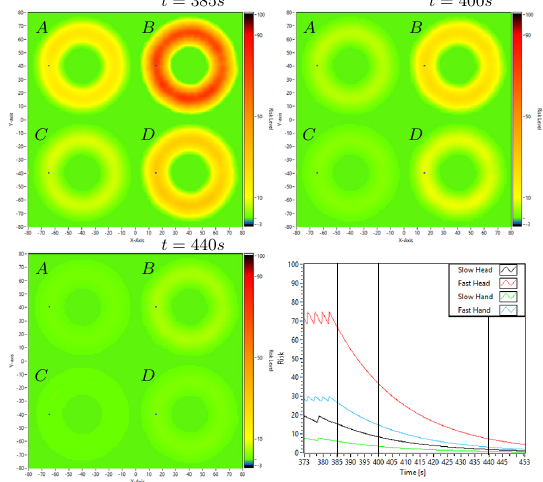
Figure 8: Degeneration of risk over time. A=Slow Head, B= Fast Head, C=Slow Hand, D= Fast Hand. The lines on the graph indicate sample